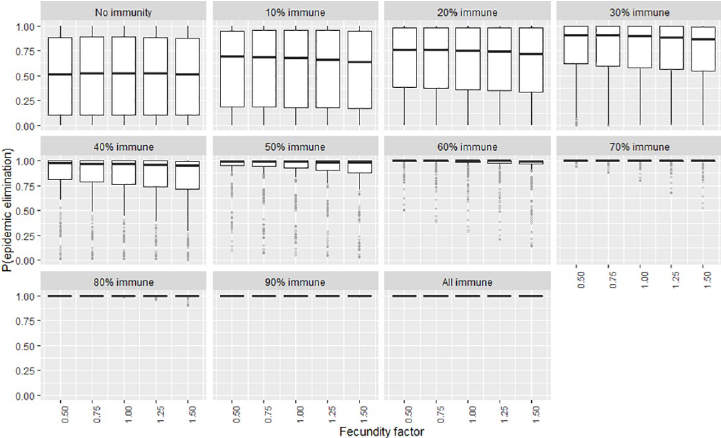
Fig 9. The certainty of the effect of the fecundity factor on P(elim.) at different herd immunities. The range of possible values when other parameters not shown in this plot are varied over their ranges. The boxplot shows the median, the interquartile range, minimums and maximums (1.5 times the 1 st and 3 rd quarter values) and outliers (grey circles).